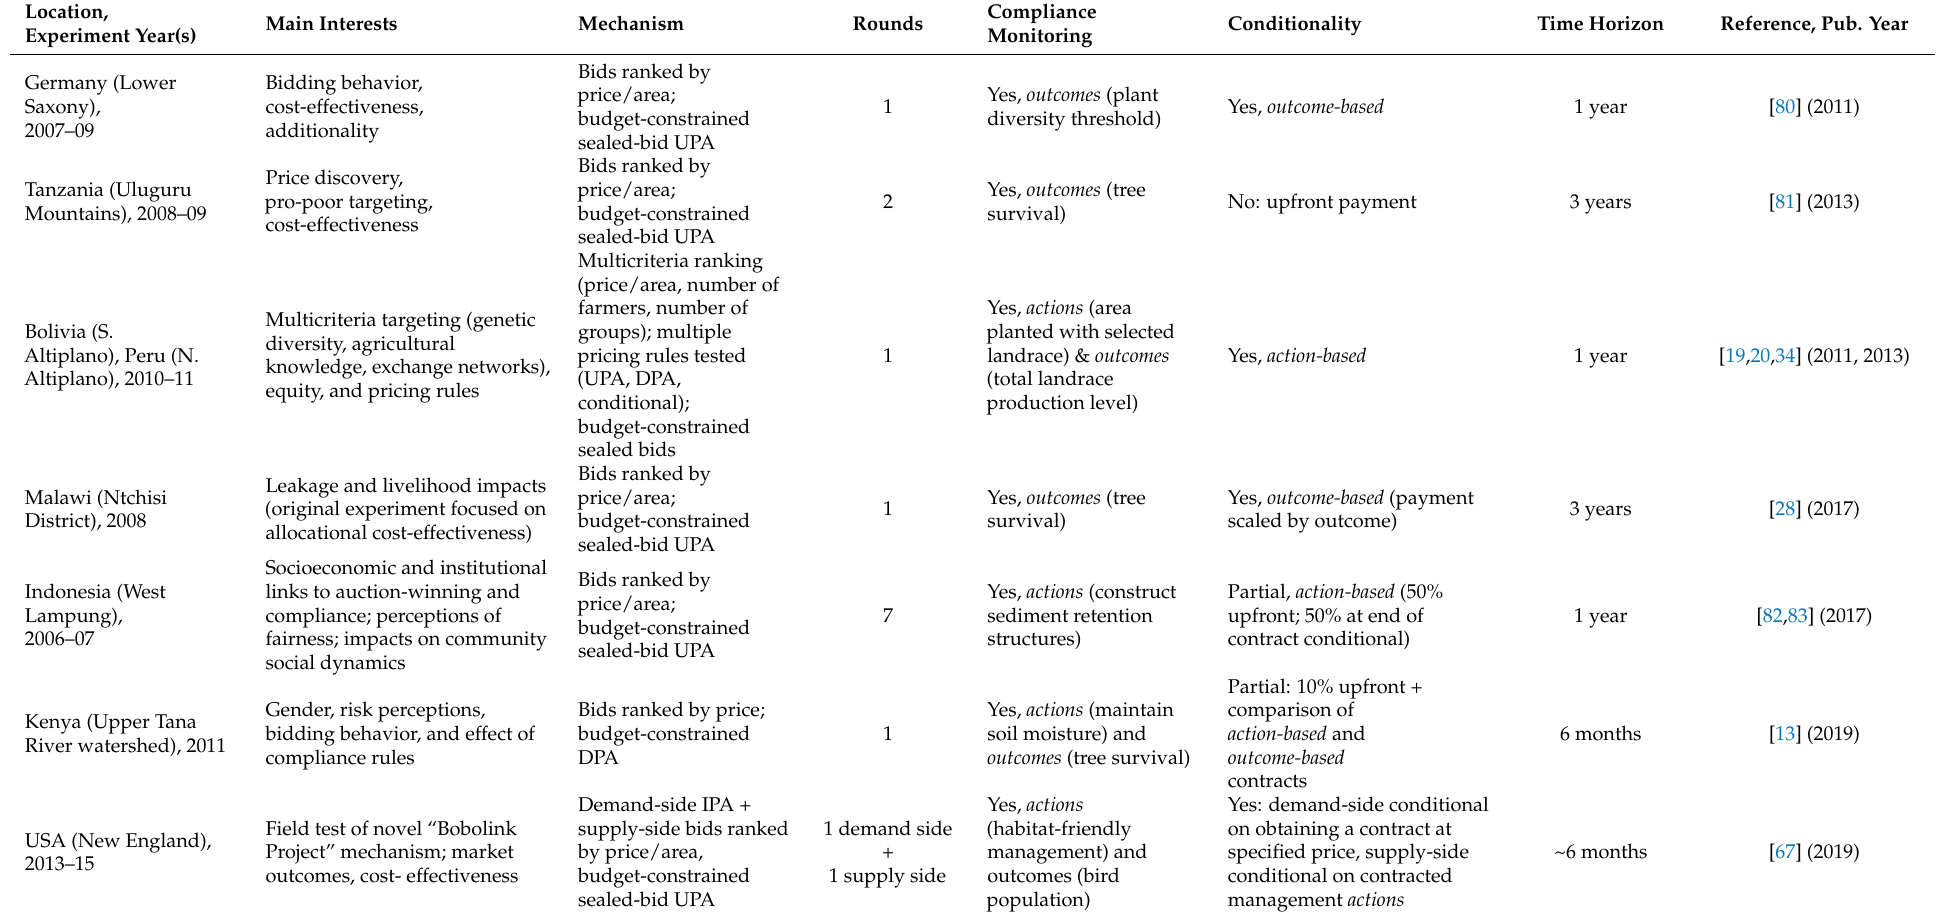
Table 2. Comparison of selected field